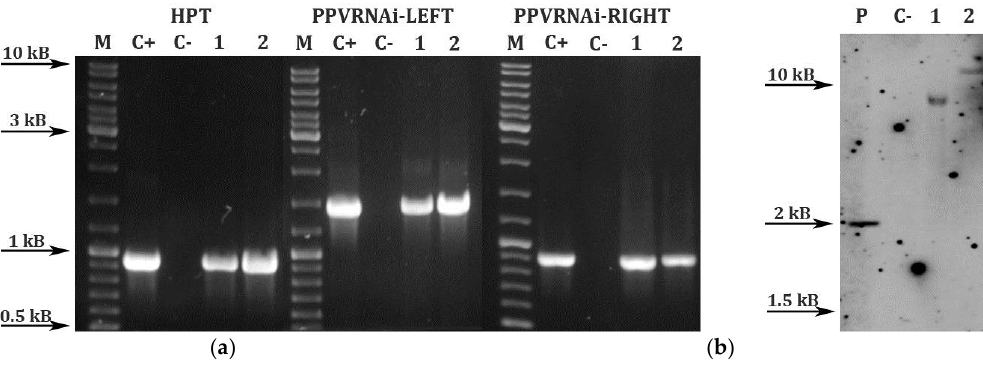
Figure 2. Analysis of transformed plum rootstock for the presence of transferred genes. ( a ) PCR analysis of AGL0:pCamPPVRNAi-transformed plum rootstock plants, where C+—pCamPPVRNAi, 1 and 2—DNA of transgenic lines; C−—genomic DNA of nontransgenic plum plant; ( b ) Southern hybridization analysis of AGL0:pCamPPVRNAi-transformed plum rootstock plants, DNA (30 μg) extracted from leaves was digested with EcoRI and hybridized with a 0.7kB PPV probe, P—DNA of pCamPPVRNAi/XbaI; 1 and 2—DNA of transgenic lines digested with EcoRI; C−—genomic DNA of non-transgenic plum plants digested with EcoRI.